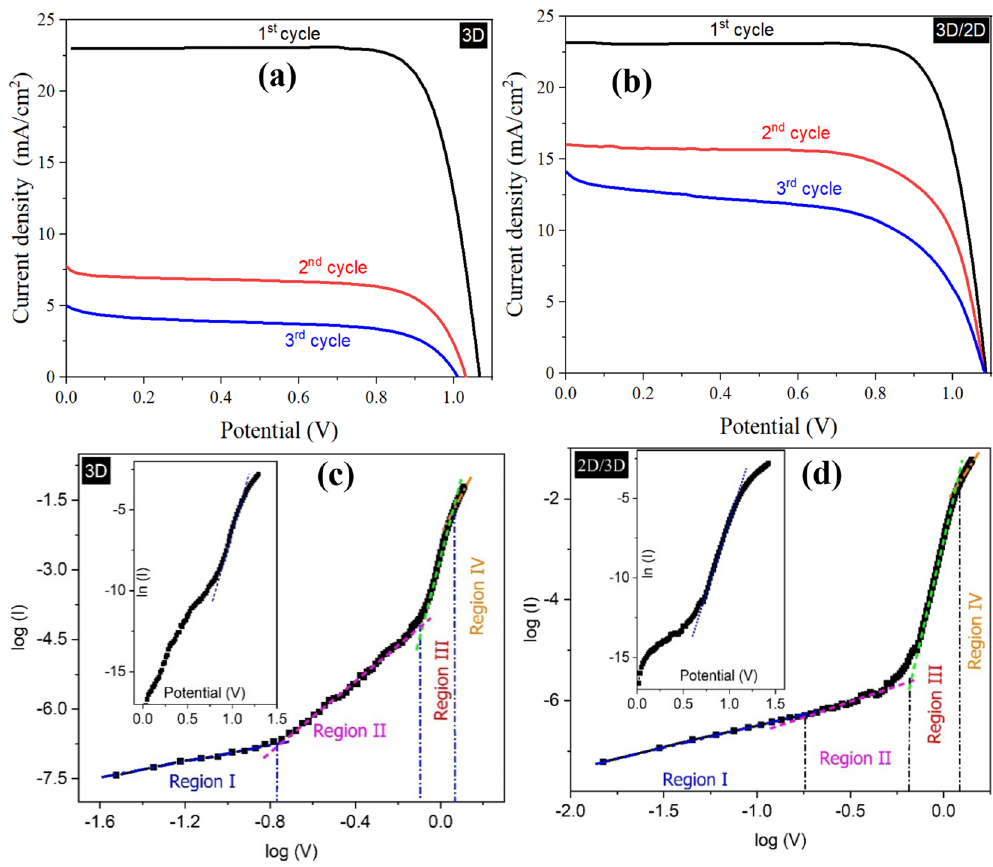
Figure 2. (a,b) J–V curves of 3D and 2D/3D perovskite solar cells under 1 Sun illumination (100 mW/cm 2 ), respectively. The J–V curves were recorded in three cycles at different intervals of time (fresh, 2500 h & 5000 h) to compare the change in the photovoltaic parameters of both 3D and 2D/3D samples. The J–V characteristics were recorded in the forward (from 0 to + V) direction at a scan rate of 25 mV/s. (c,d) represents the I–V curves of 3D and 2D/3D perovskite solar cells, respectively, under dark